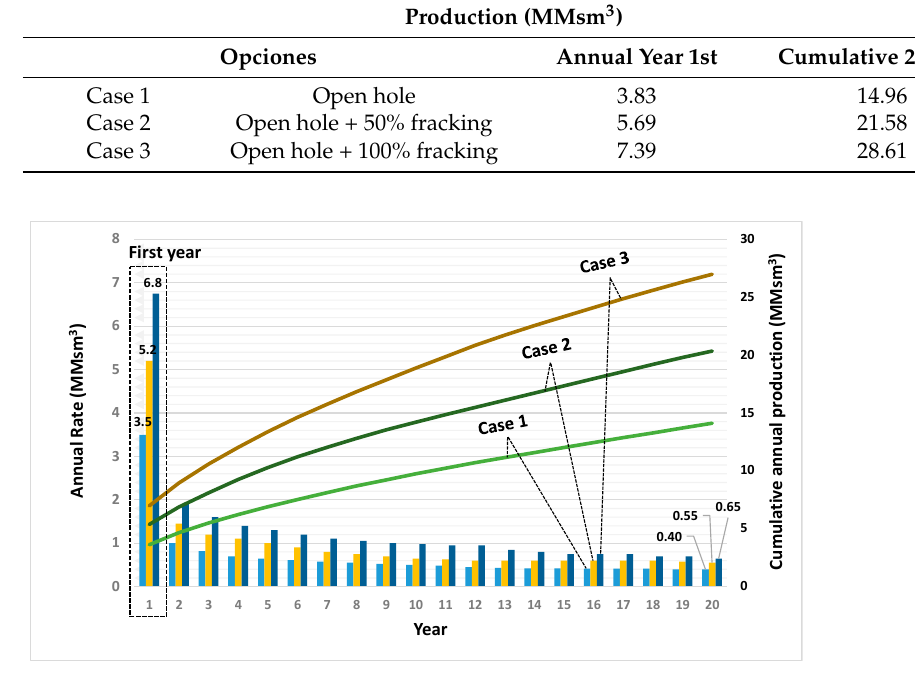
Figure 6. Estimated production based on production data from the Serrablo-13 well. Case 1: open well, Case 2: open well +50% fracking, Case 3: open well +100% fracking.